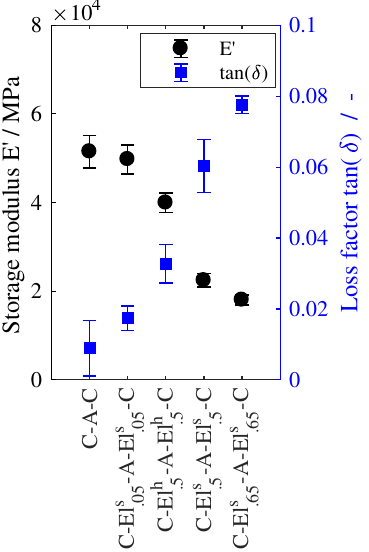
Figure 6. Storage module and loss factor for all specimens with CFRP on the outside at 20 ◦ C and 1 Hz. Three specimens for each